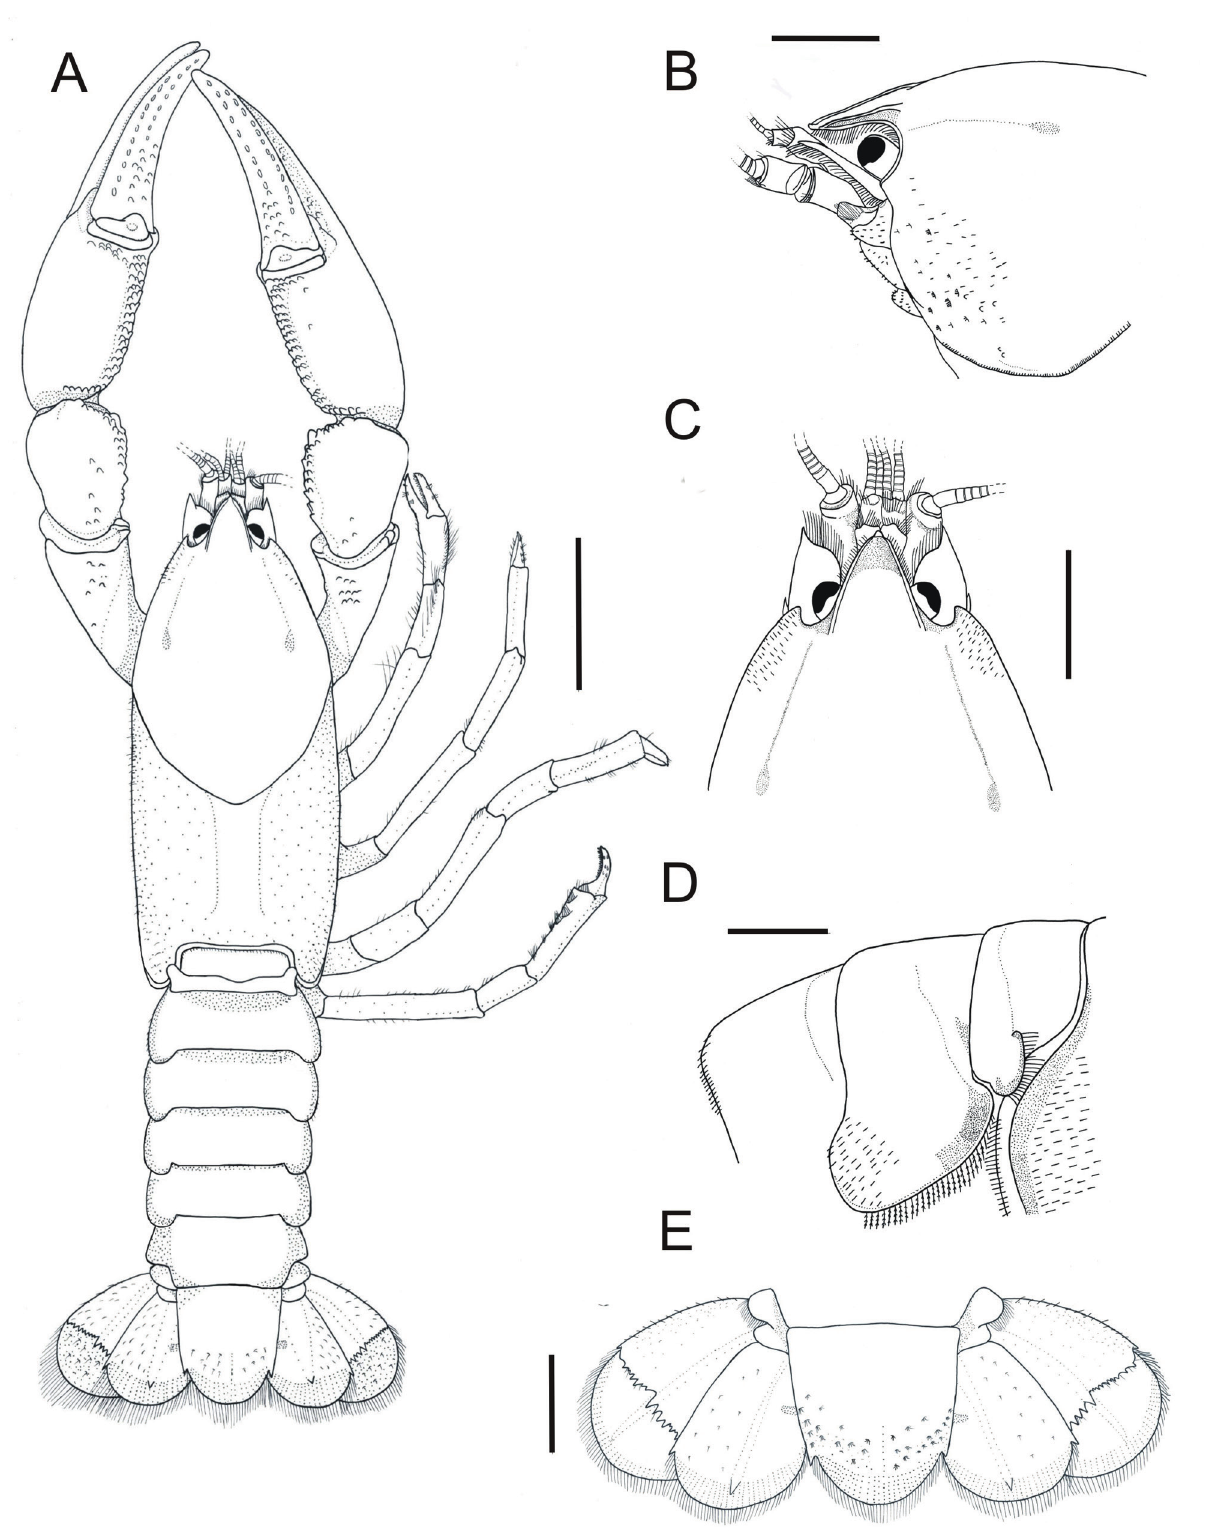
Figure 1. Parastacus tuerkayi sp. nov., holotype (MZUSP 34940). A, habitus, dorsal view; B, cephalon, lateral view; C, cephalon, dorsal view; D, first and second abdominal pleura; E, telson and uropods, dorsal view. Scale bars: A = 1 cm; B – E = 5